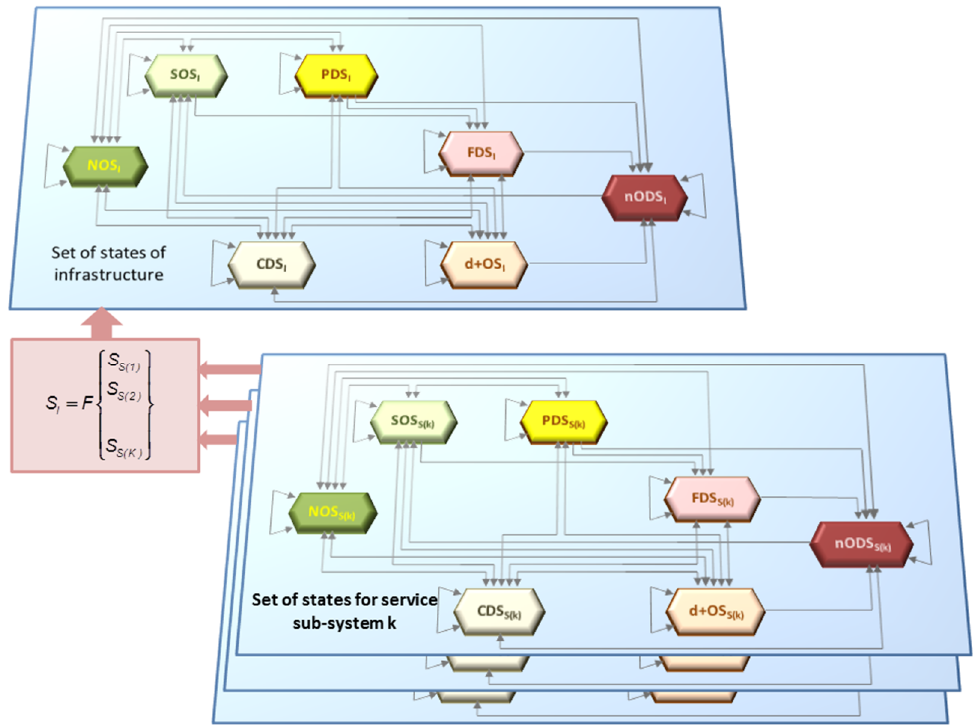
Figure 1. Infrastructure’s states of service provision (gray lines indicate the principle bidirectional transitions between states, including the remaining in a state corresponding to Table 2) and the relation to the states of sub-systems.